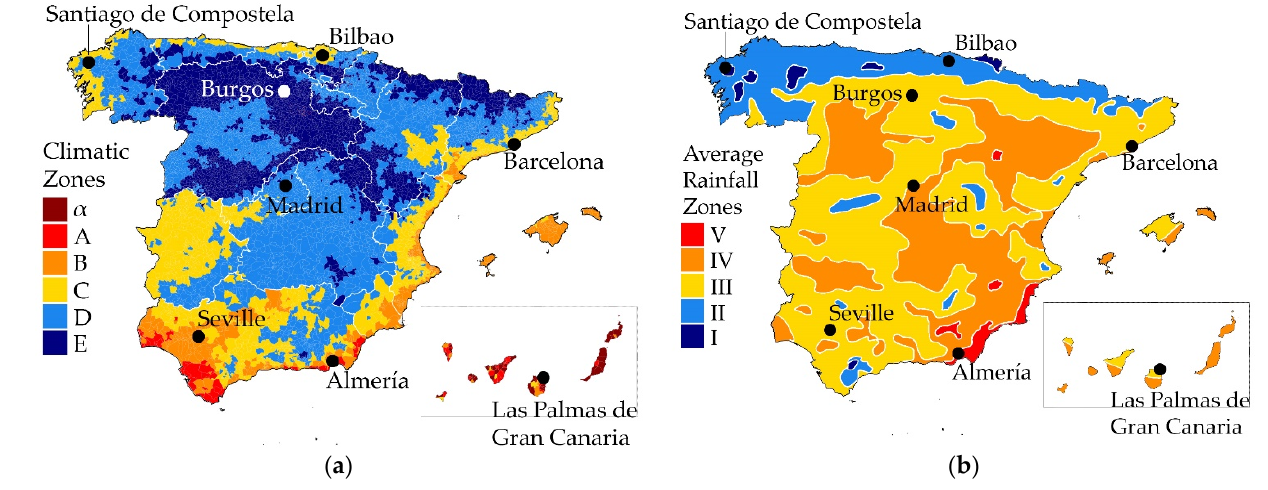
Figure 1. Location of cities and ( a ) climatic zones and ( b ) average rainfall zones. Table 1. Climatic and average rainfall zones of each city. Thickness of the roof’s insulation material layer.